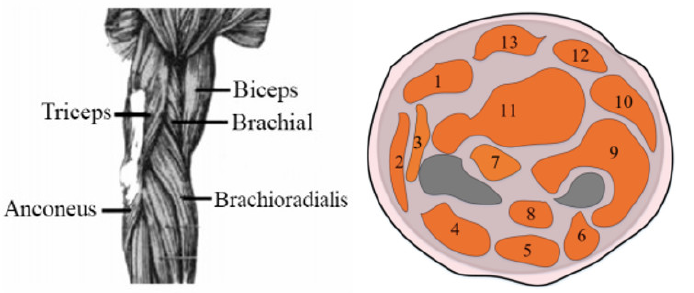
Figure 2. Elbow joint muscle contribution during isometric contraction. In order: 1. Extensor Carpi Radialis Longus, 2. Flexor Digitorum, 3. Pronator Teres, 4. Extensor Digitorum Communis, 5. Palmaris Longus, 6. Extensor Carpi Ulnaris, 7. Flexor Pollicis Longus, 8. Extensor Pollicis Longus, 9. Brachioradialis, 10. Flexor Pollicis Longus, 11. Biceps, 12. Flexor Carpi Ulnaris, 13. Flexor Carpi